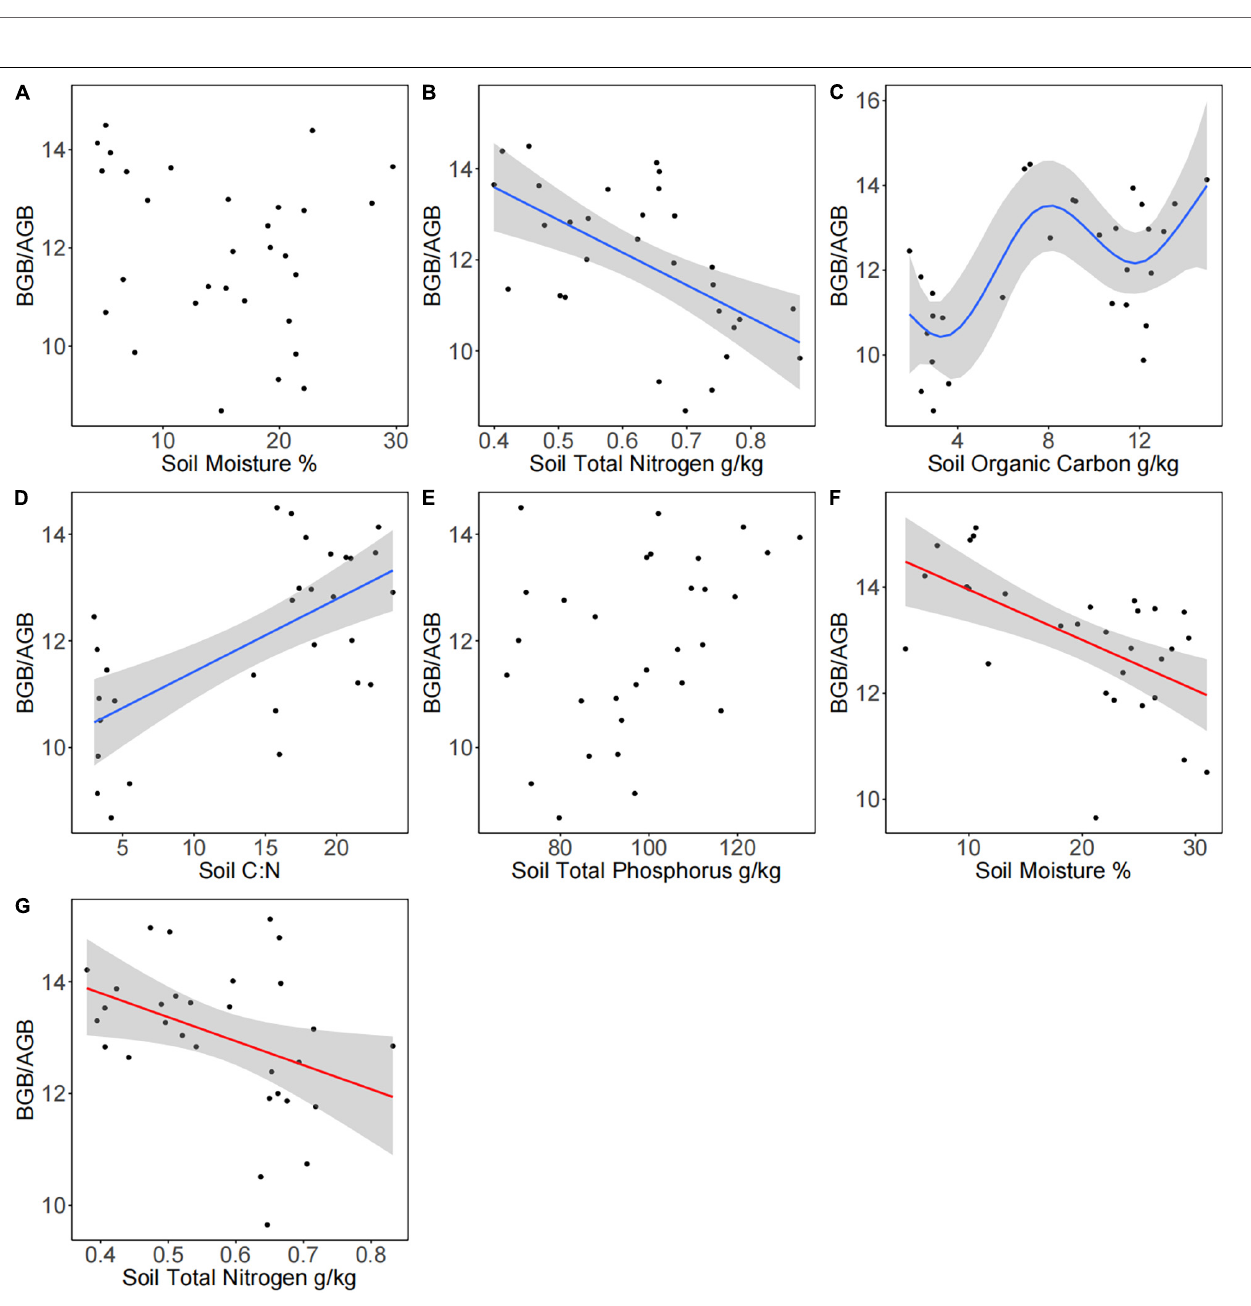
FIGURE 5 | Relationships between environmental factors and the ratio of BGB to AGB in the presence and absence of plateau pikas in alpine meadows. The effects of (A) soil moisture, (B) STN, (C) SOC, (D) soil C:N, and (E) STP on the BGB/AGB in the presence of plateau pikas. The effects of (F) SM and (G) STN on BGB/AGB in the absence of plateau pikas. Ten replicates within each of the three sites in the presence ( n = 30) and absence ( n = 30) of plateau pikas are presented. The best-fit GAM had a significant p -value ( p < 0.5), the lowest Akaike information criterion (AIC), the lowest generalized cross-validation (GCV), and the highest r -squared values, and site was included as a random